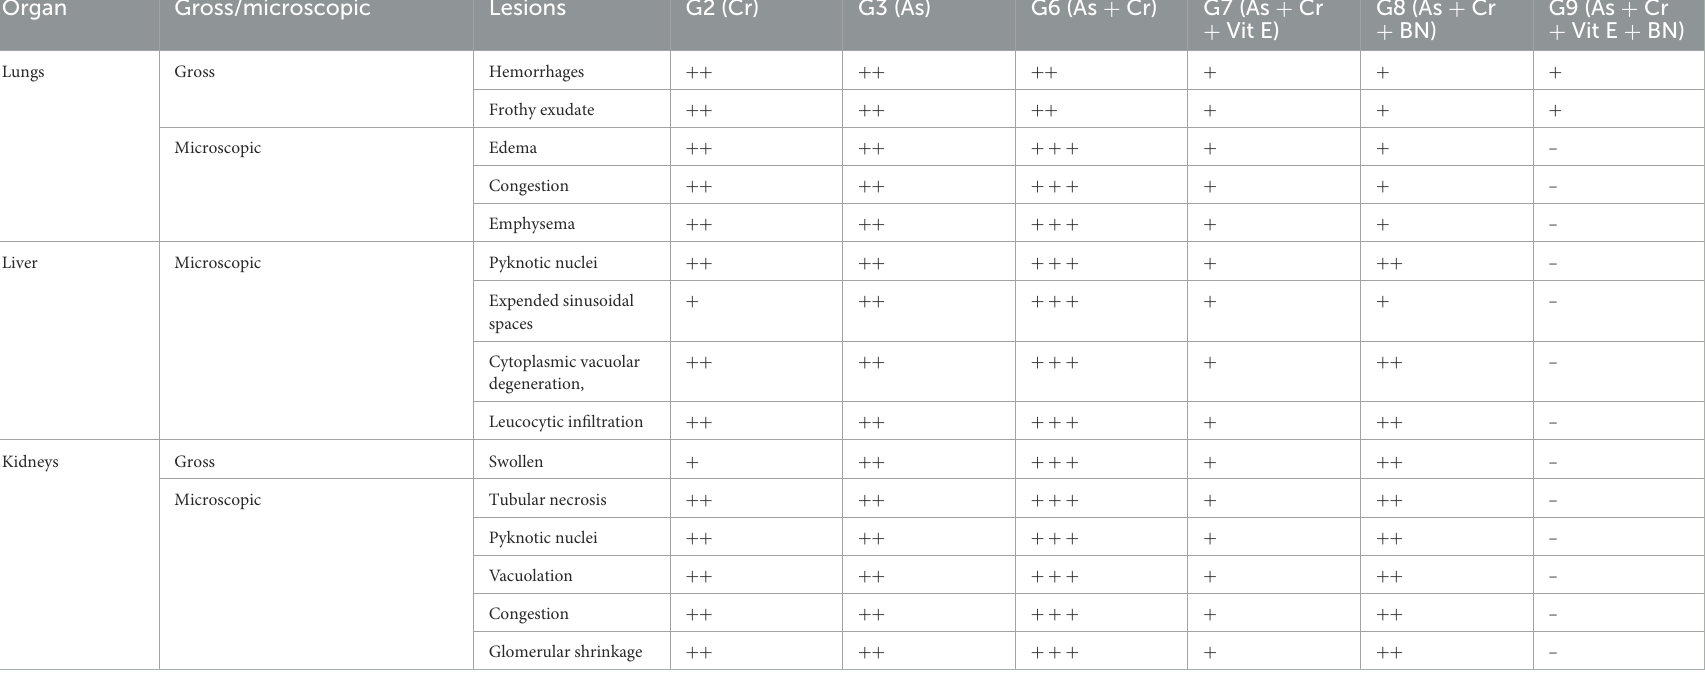
TABLE 8 Gross and microscopic lesions recorded in broiler chicks administered arsenic, chromium, bentonite, and vitamin E, alone or in combinations.